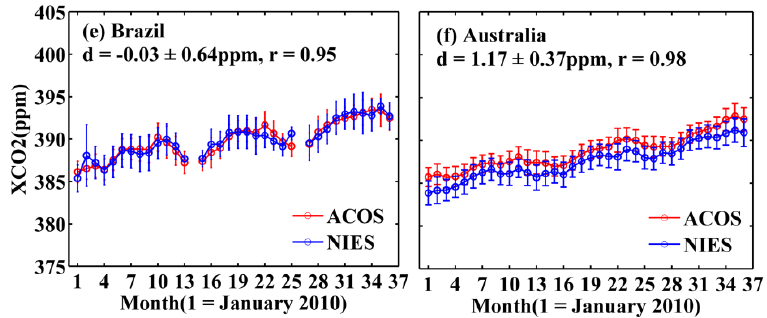
Figure 7. The same as Figure 6 but for six countries or regions. There are some XCO 2 monthly means unavailable over Russia and Brazil.